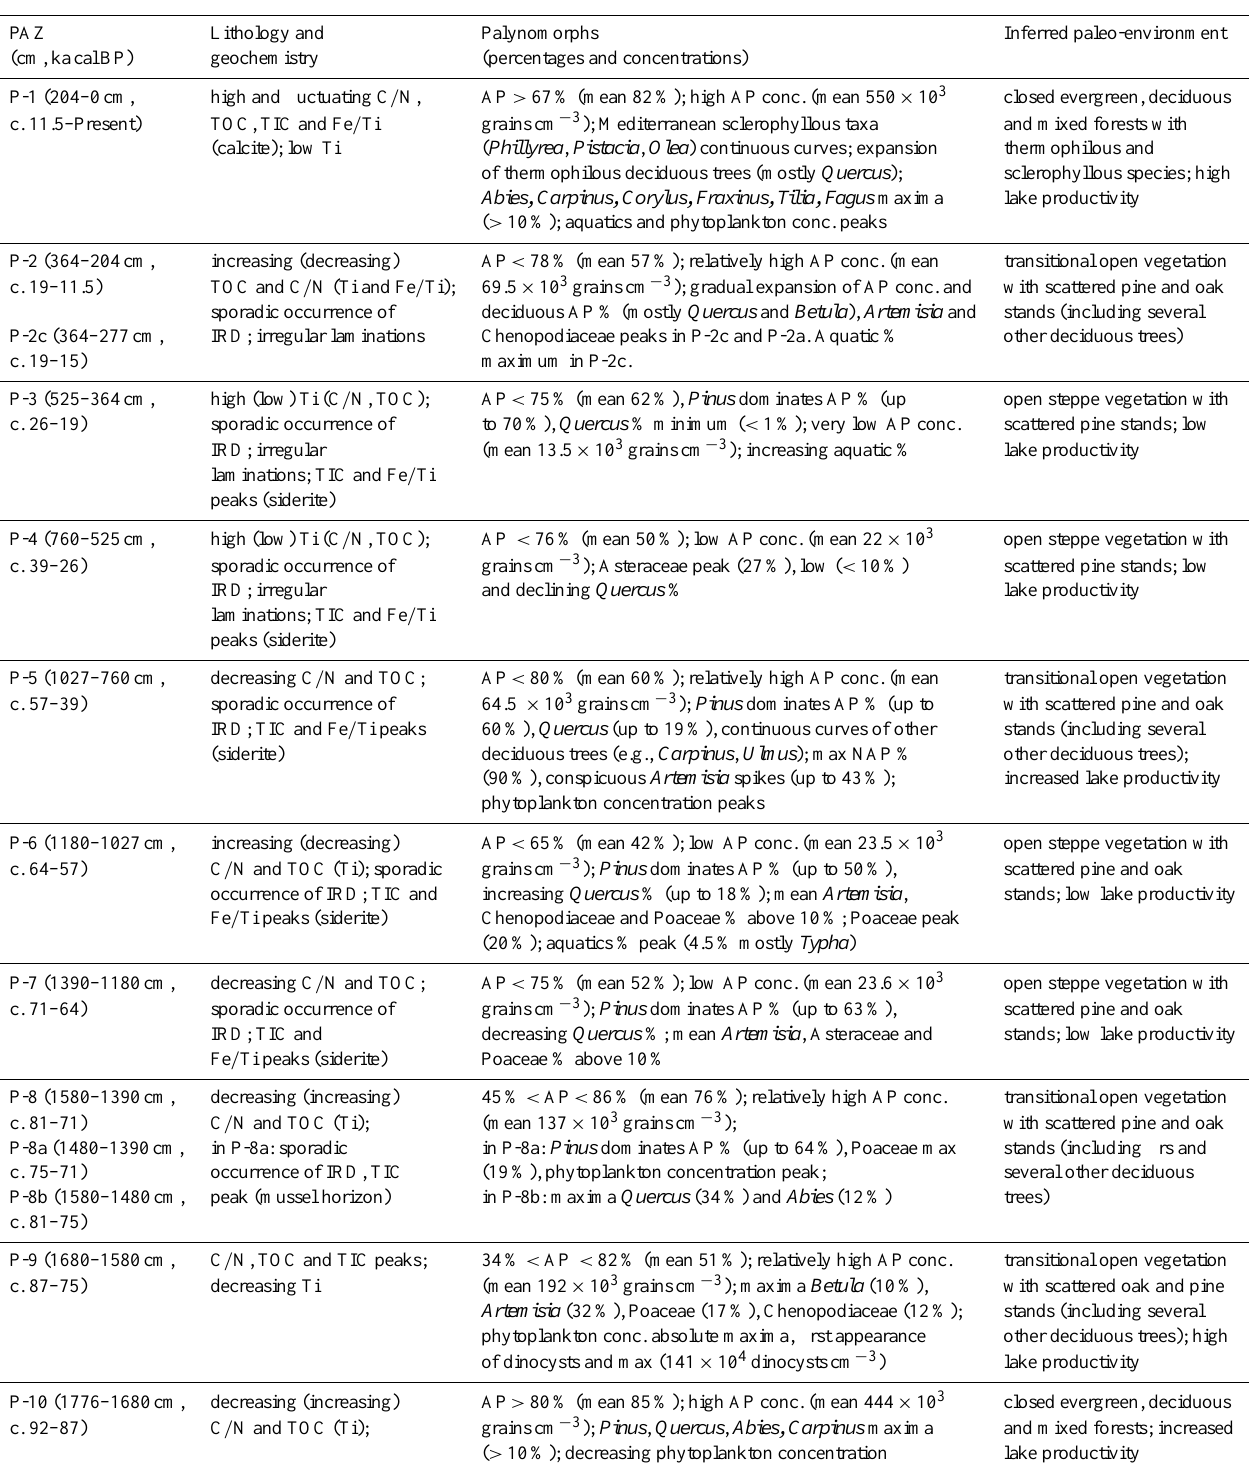
Table 1. Pollen assemblage zones (PAZ) in Co1215, including lithology, geochemistry and inferred paleo-environment.